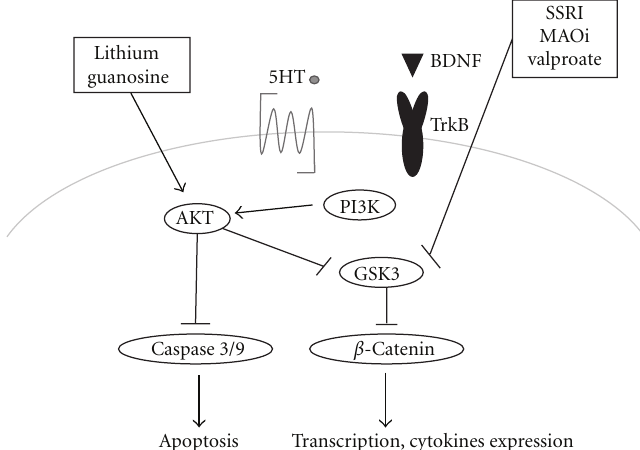
Figure 3: Potential antidepressant molecular targets based on the predominant PI3K/AKT/GSK3 pathways. Note that some critical events have been omitted for clarity. SSRI: selective serotonin reuptake inhibitors; MAOi: monoamine oxidase inhibitors; BDNF: brain-derived neurotrophic factor; 5-HT: 5-hydroxytryptamine,